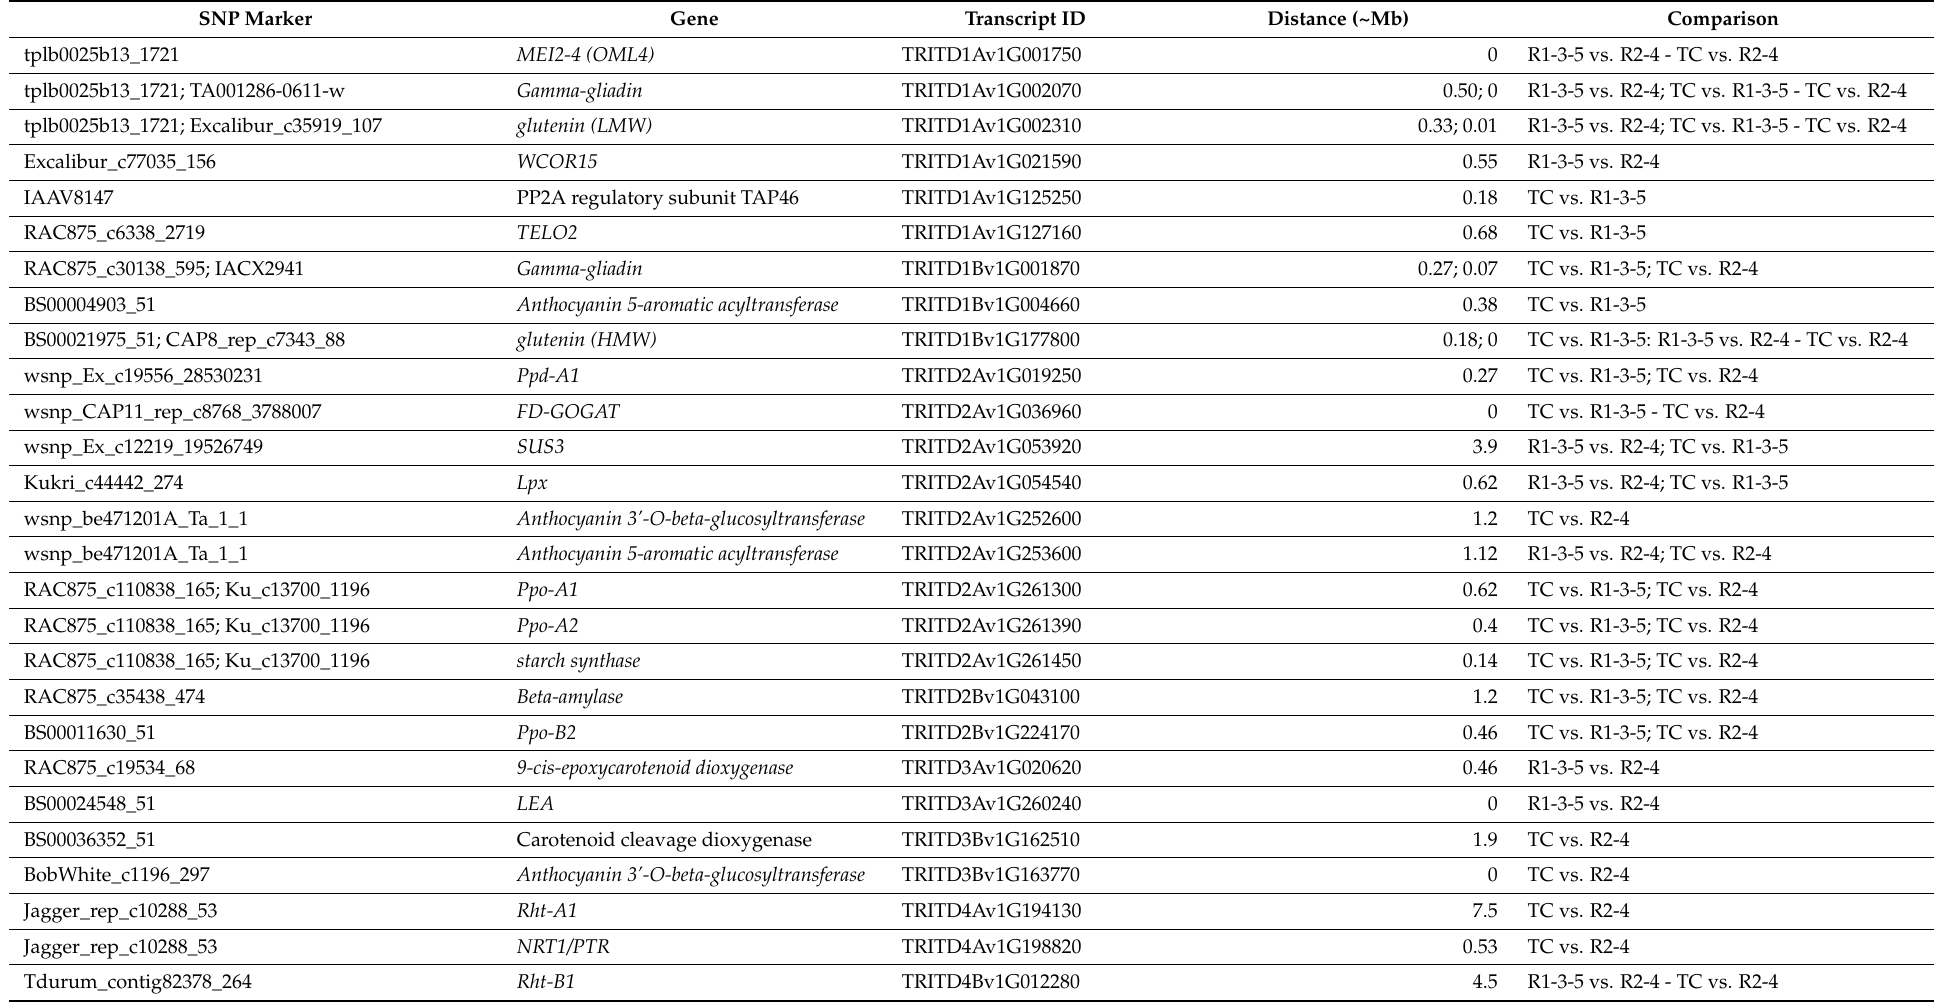
Table 2. Major genes detected in the flanking region of divergent SNPs exceeding the significant threshold of F ST > 0.80. SNP name, chromosome, and position on “Svevo” genomes, distance (Mb) between divergent SNP and genes, transcript ID, and pairwise comparison are